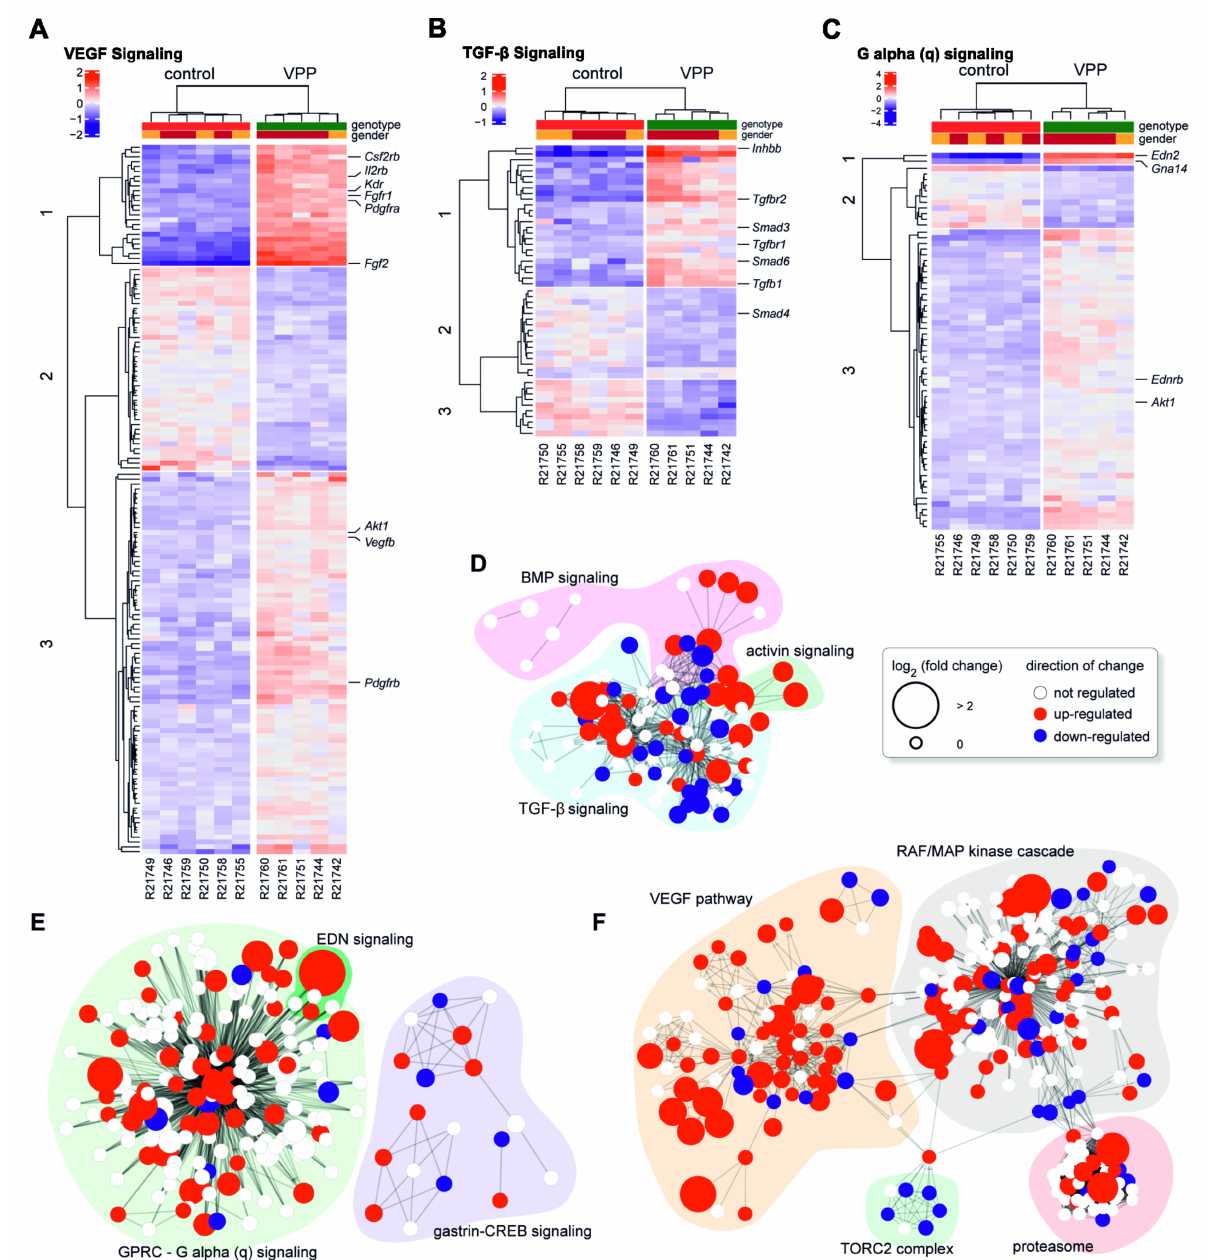
Figure 2. Pathway analyses of transcriptomic changes in VPP mice. ( A – C ) Heatmaps showing the significantly dys- regulated genes in the Reactome pathways VEGF signaling ( A ), TGF- β signaling ( B ), and G alpha (q) signaling ( C ). For each heatmap, the genotypes separate perfectly, as indicated by the unsupervised clustering above the heatmaps. Colors (red: upregulated, blue: downregulated) represent the deviation of the mean expression for each gene, independent of genotype. K-mer analysis into three groups revealed clusters of tightly co-regulated genes. Some interesting genes (e.g., neuroprotective or immune modulating function, directly involved in the intracellular signaling) are highlighted on the right. To further visualize sub-groups of pathways that were dysregulated, we converted the Reactome pathways into functional interaction networks. For each network, genes were colored according to their dysregulation state: white—not significantly dysregulated; red—significantly upregulated; and blue—significantly downregulated. The size of the nodes corresponds to the log2-fold change of regulation. The network for TGF-beta signaling is shown in ( D ), G alpha (q) signaling is shown in ( E ), and VEGF signaling is shown in ( F ); R21742-61 = RNAseq sample